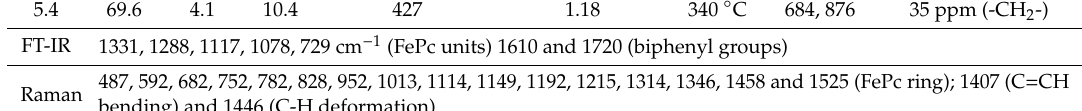
Table 1. Characterization data of FePc-POP.